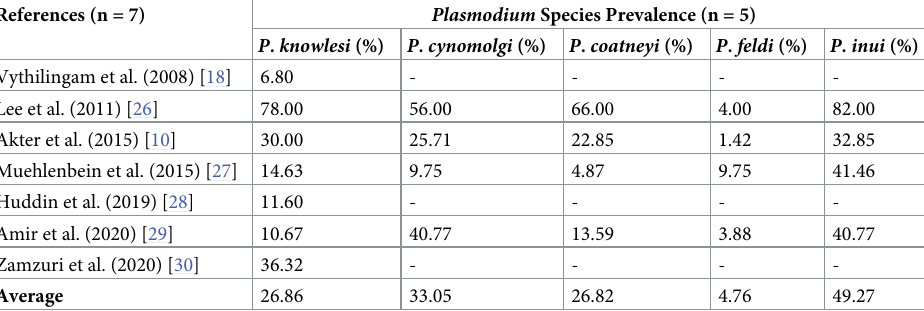
Table 2. The Plasmodium species prevalence in selected articles.